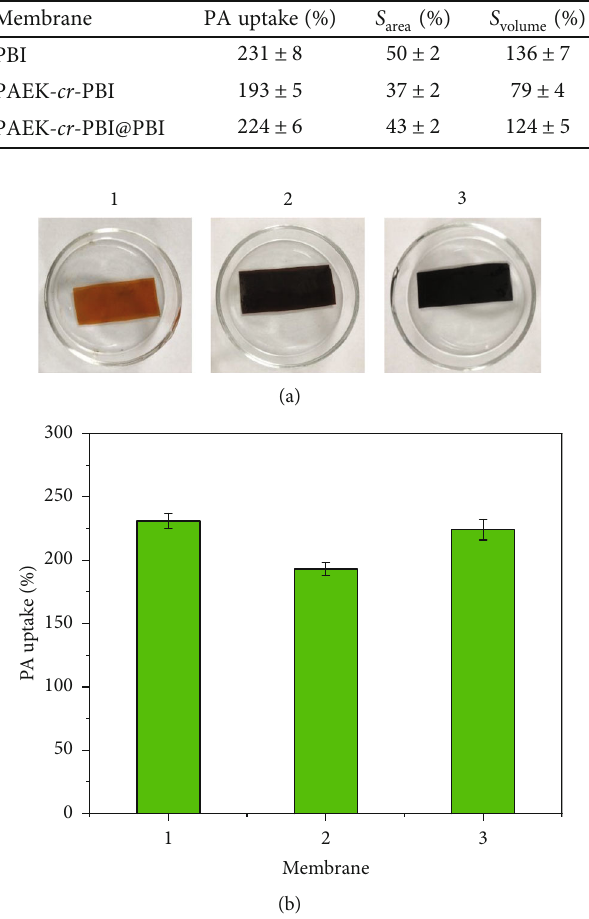
Figure 8: (a) Photographs of the PA-doped membrane and (b) PA uptake of the membranes: (1) PBI, (2) PAEK- cr -PBI, and (3) PAEK- cr